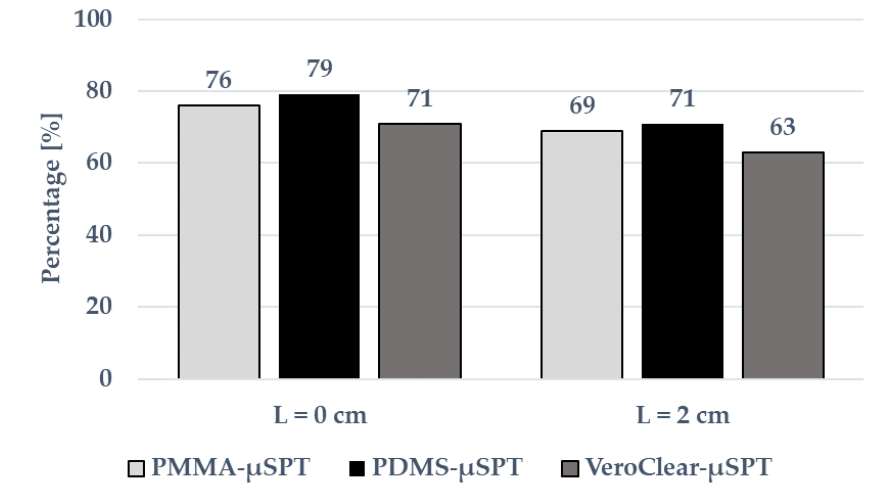
Figure 3. Histogram of the percentage of rays, obtained by ray-tracing simulations, reaching the output fiber surfaces for two different lengths L = { 0;2 } cm and for the PMMA- µ SPT , the PDMS- µ SPT , and the VeroClear- µ SPT . Bar errors have not been added because they were narrower than the bar